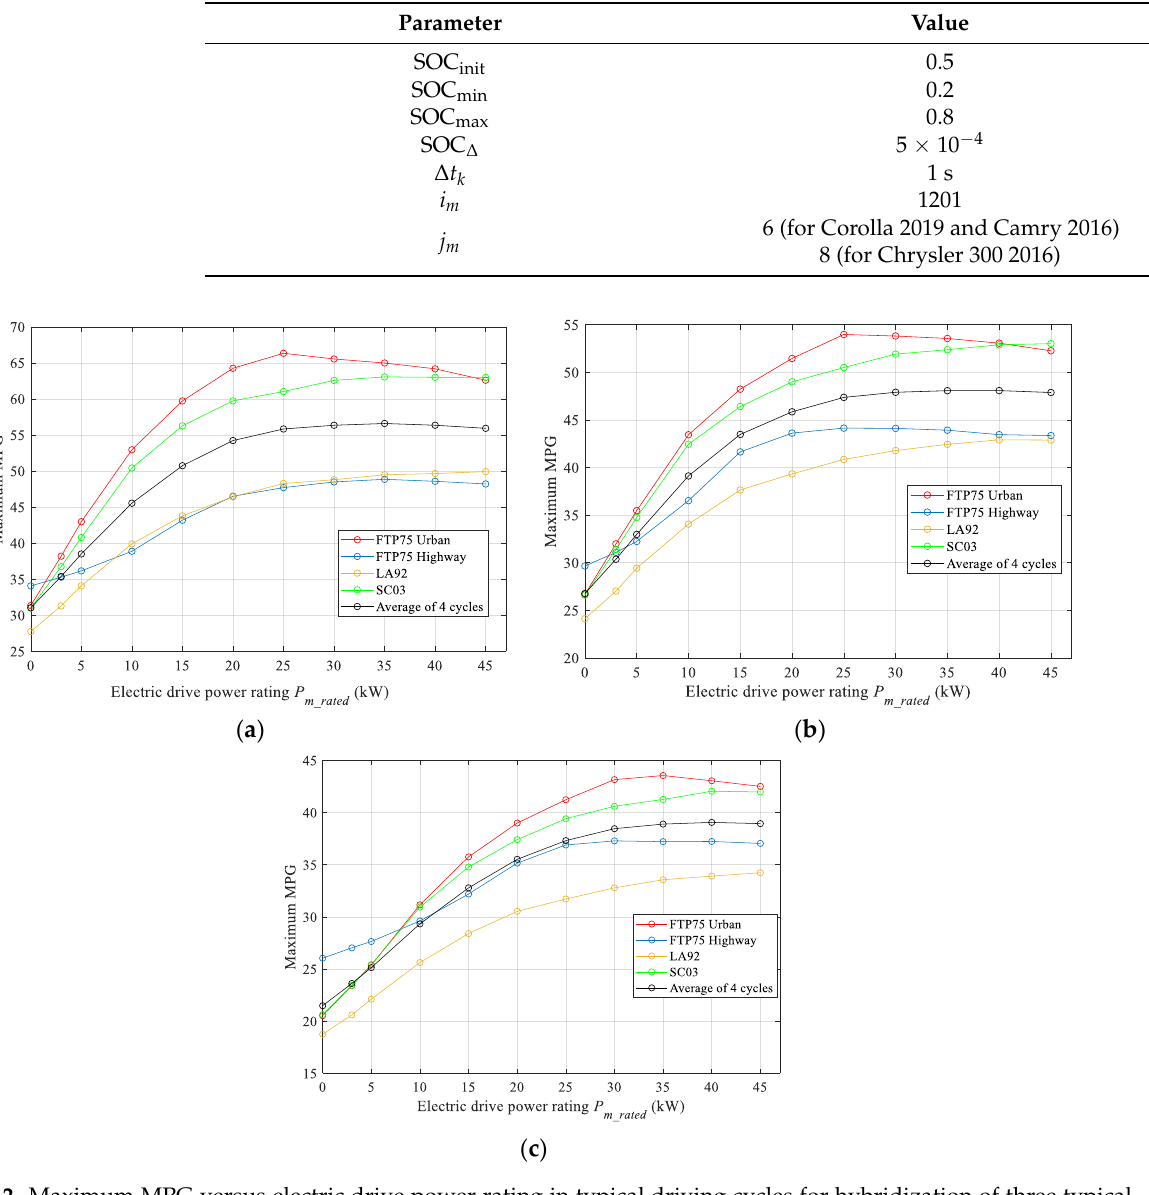
Table 4. Parameters of the DP algorithm.